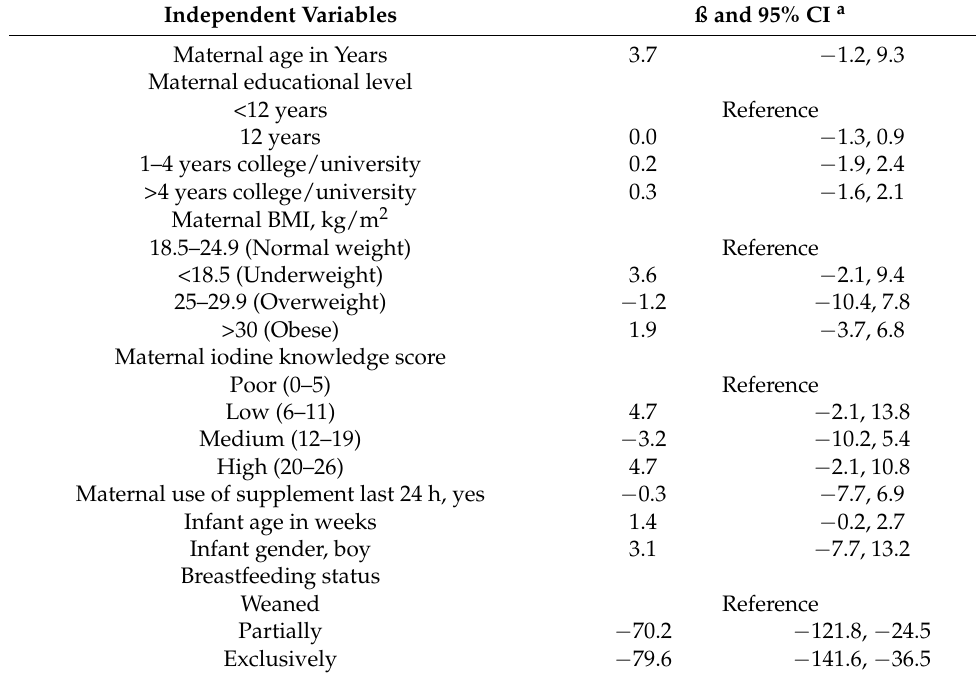
Figure 3. Prediction plot of infant urinary iodine concentration by maternal breastmilk iodine con- centration for exclusively breastfed infants. n = 56.